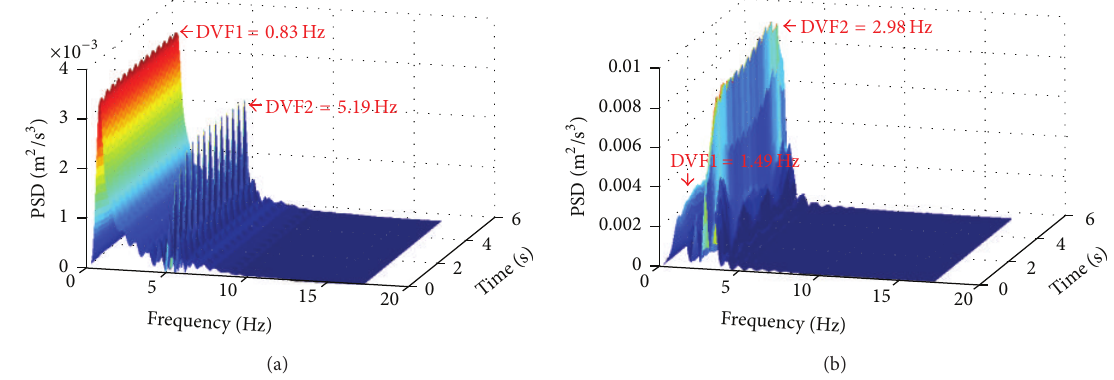
Figure 5: PSD of acceleration of trailer carbody. (a) Vertical. (b)